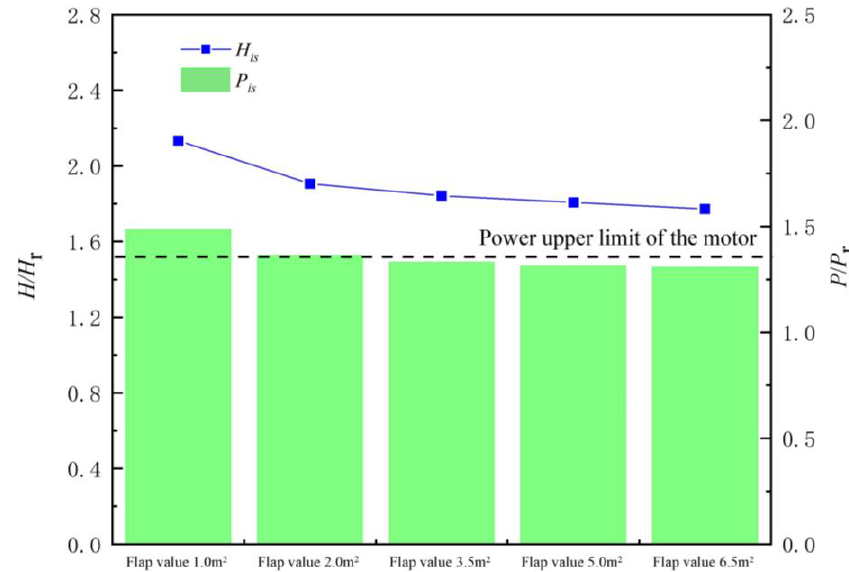
Figure 12. H is and P is of LAPS with FLVA under gate refusal working conditions.